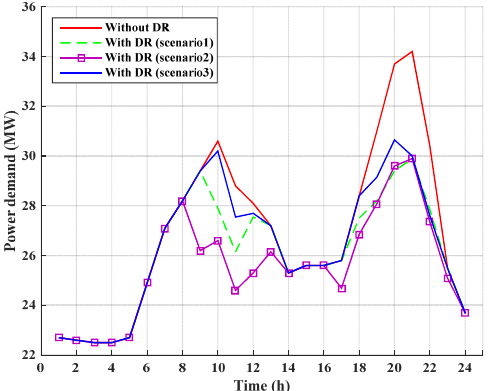
Figure 13. Total load profile with and without considering DR programs in different scenarios.